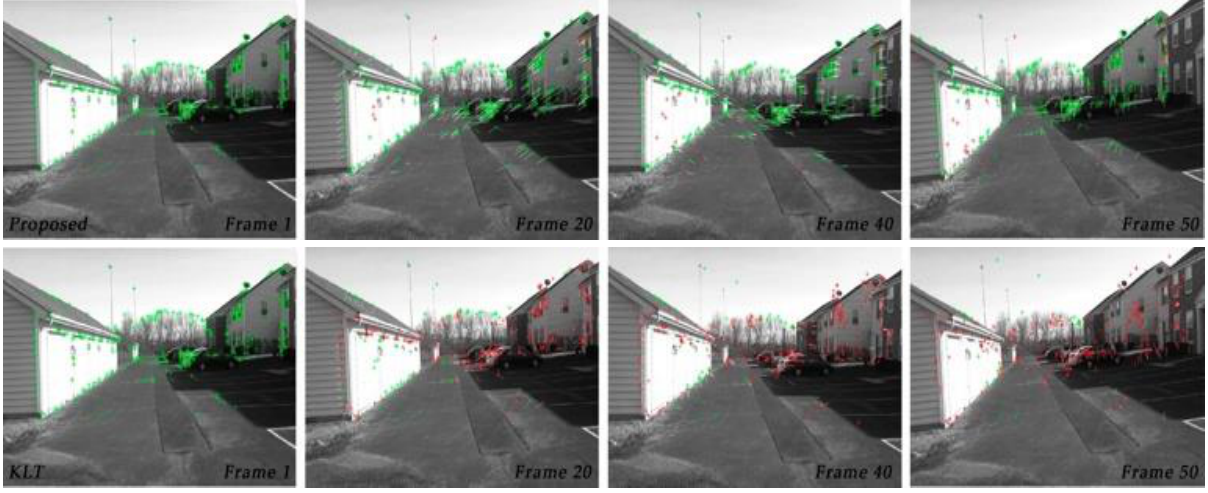
Figure 2. Tracking comparison between the proposed method (top) and KLT (bottom) shows a significant tracking improvement when geometric constraints are added to the system. While KLT struggles with motion blur and large displacements, the object shape in the proposed method retains tracking accuracy.